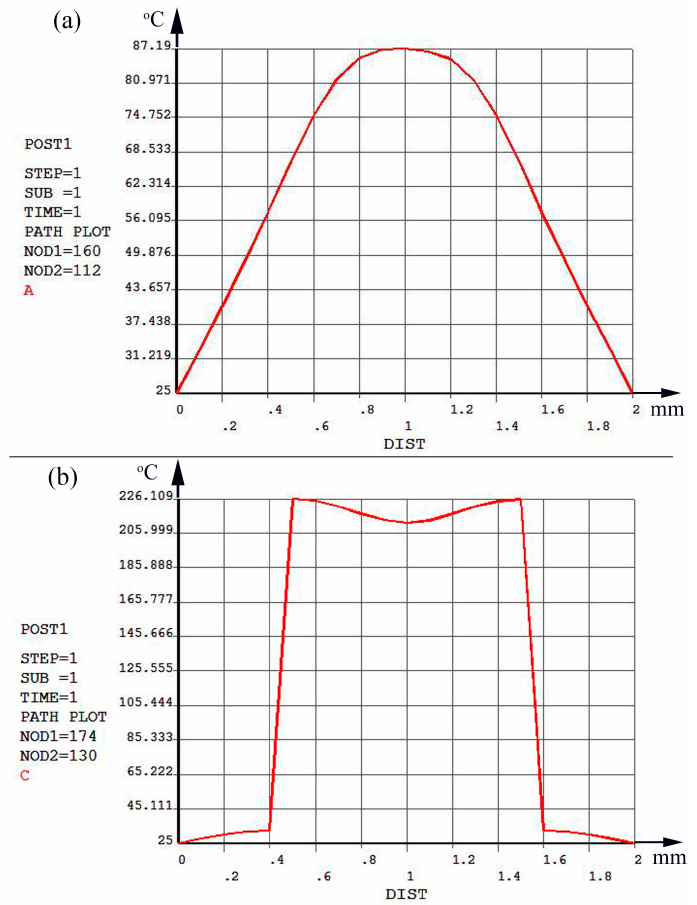
Figure 4. Radial temperature distribution curves ( a ) before thermal isolation ( b ) and after thermal isolation of the thermal structure simulation of a micro hotplate sensor.